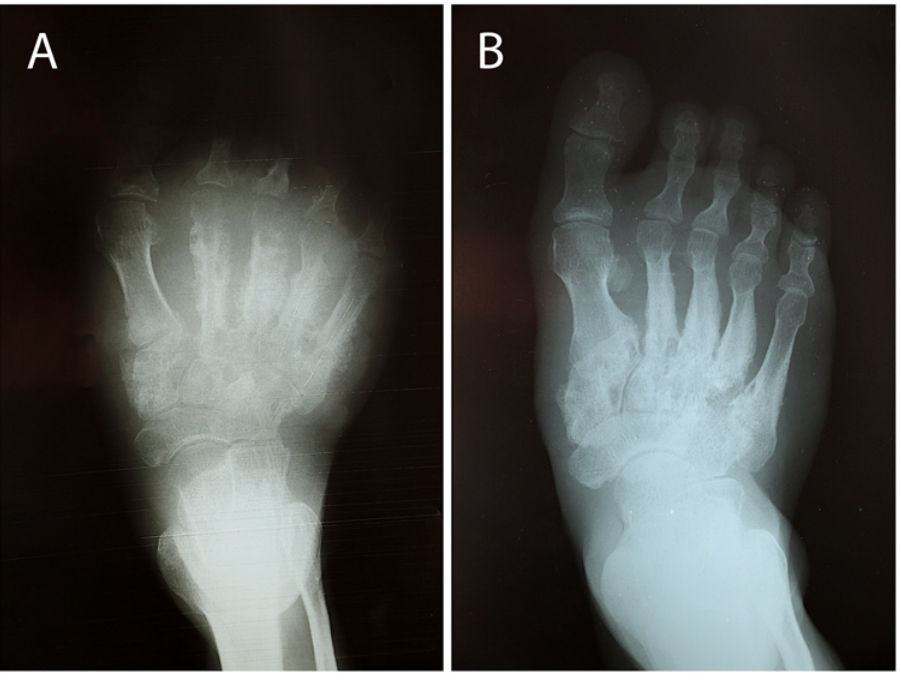
Fig 2. X-ray of right foot before (A) and 10 months after treatment